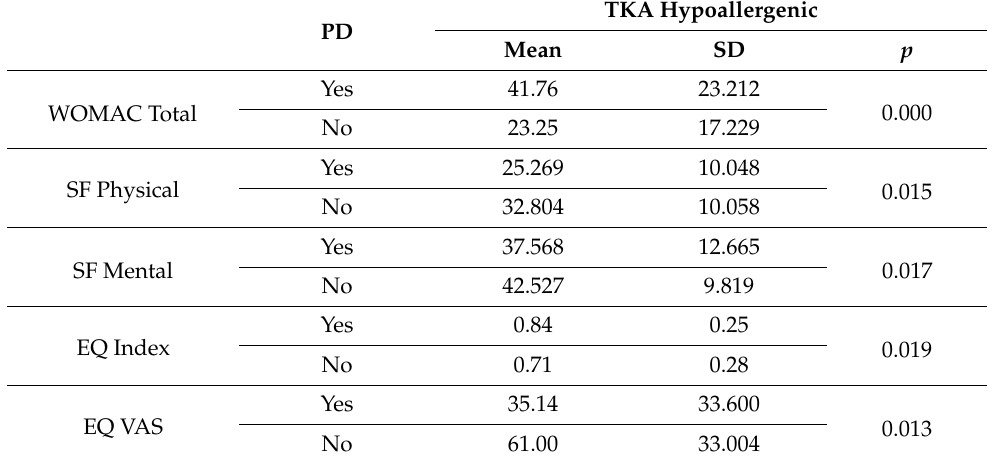
Table 4. Student’s t results for independent samples of preoperative psychological distress in patients treated with hypoallergenic implants with respect to the results of the questionnaires (WOMAC, 20 patients). The results are presented as the mean ± standard deviation